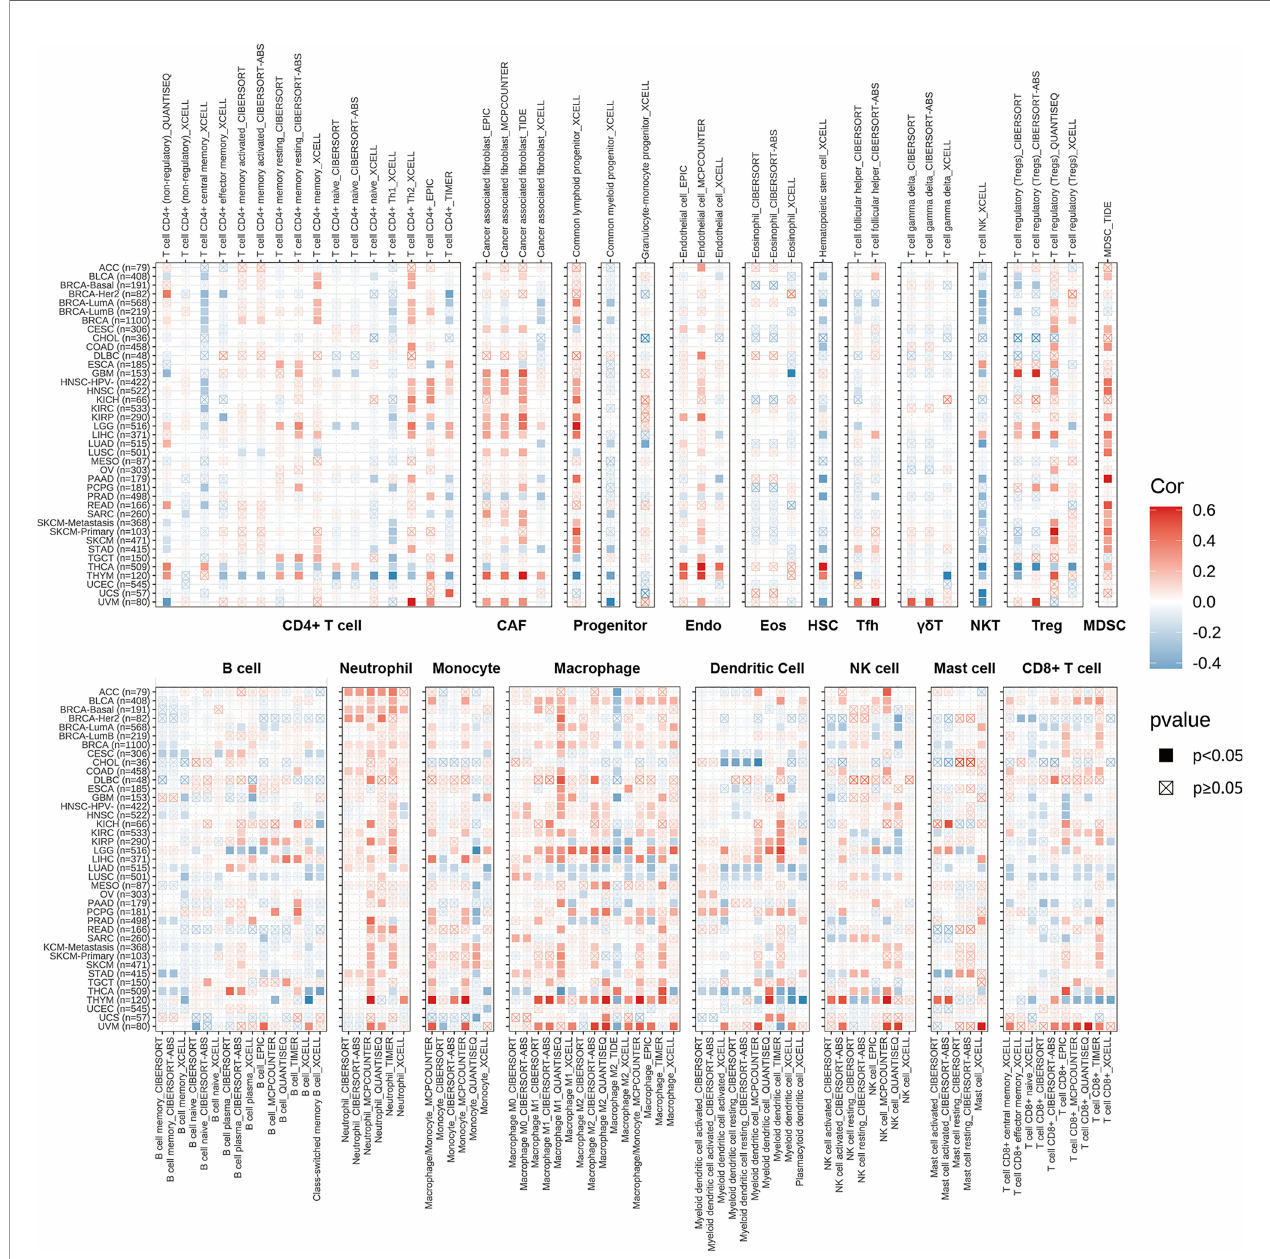
FIGURE 5 | The correlations of PDIA3 expression and the in fi ltration levels of CD4+ T cells, CAF, progenitor, Endo, Eos, HSC, Tfh, gd T, NKT, regulatory T cells (Tregs), B cells, neutrophils, monocytes, macrophages, dendritic cells, NK cells, Mast cells and CD8+ T cells in cancers. Positive correlation in red and negative correlation in